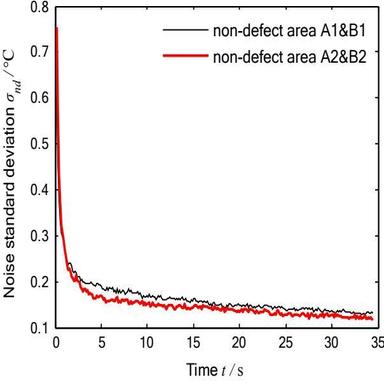
Comparison between the simulation result and the experimental result of the running temperature contrast for defect A1 of sample B.